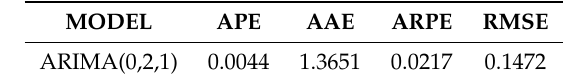
Table 5. Prediction error by ARIMA(0,2,1)